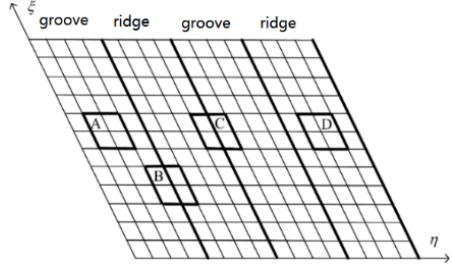
Figure 3. Schematic diagram of meshing.